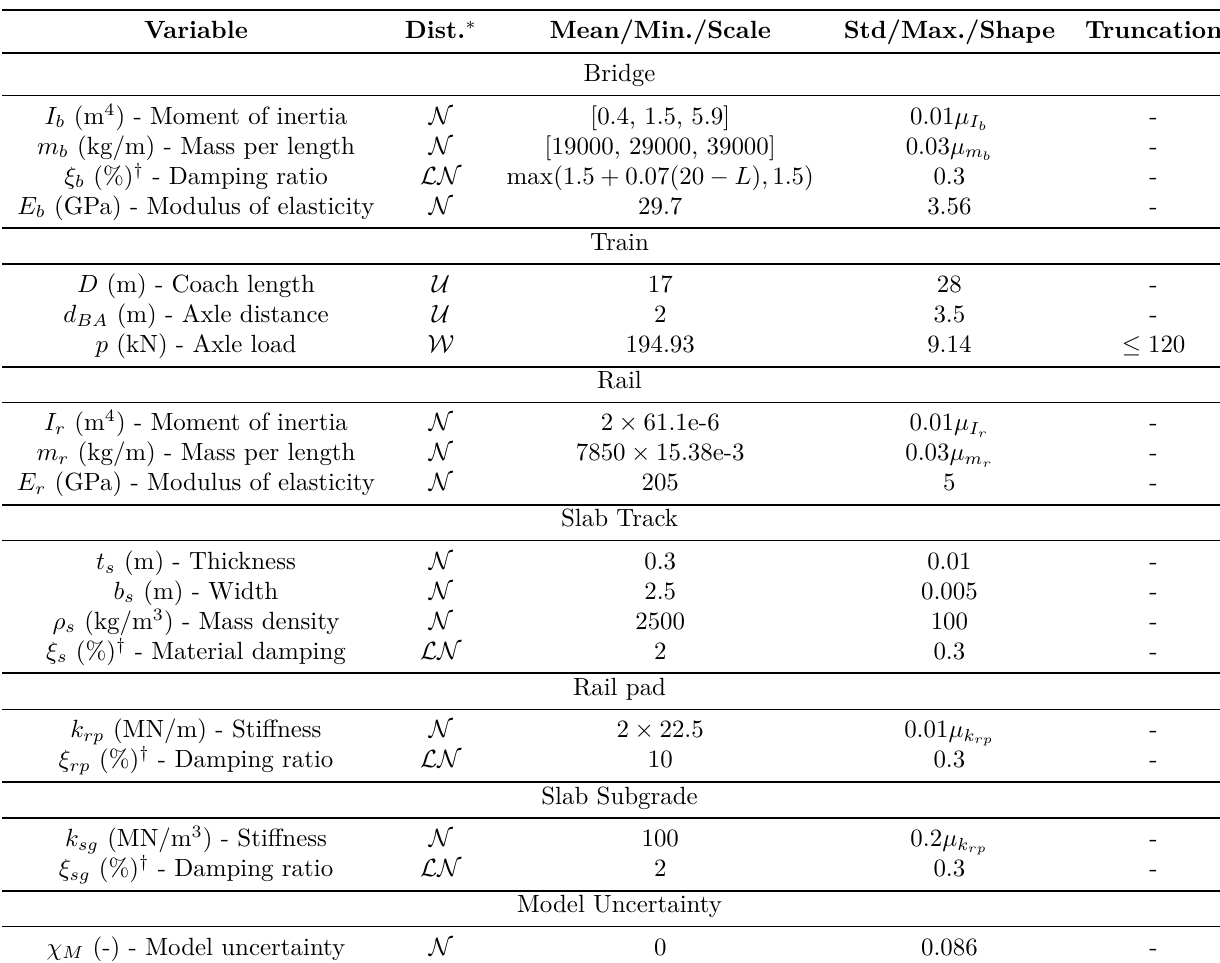
Table 1. Considered basic random